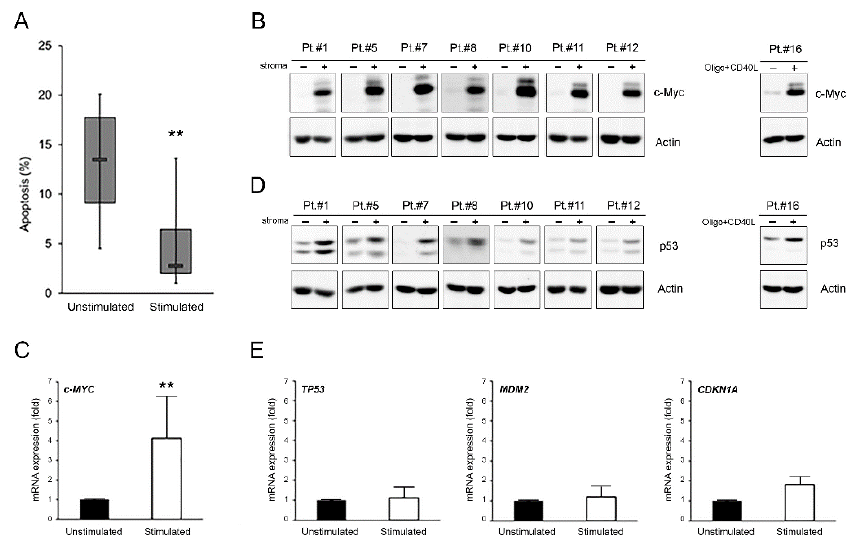
Figure 1. c-MYC and p53 induction in microenvironment-activated B-CLL cells. Patients’ derived B-CLL cells were stimulated (with stroma or CpG-ODN and CD40L) for 24 – 48 h or grown unstimulated in suspension as control. In ( A ), baseline apoptosis level, indicated as percentage of Annexin V/PI double positive cells, was comparatively assessed in B-CLL cells unstimulated and stimulated with stroma at 48 h. Horizontal bars are median, upper and lower edges of box are 75th and 25th percentiles, lines extending from box are 10th and 90th percentiles. The two asterisks indicate p < 0.01 with respect to unstimulated cells (Student’s t -test). Results are reported as mean ± SD of four independent experiments. In ( B , D ), Western blotting analyses of c-MYC and p53 protein levels are shown at 24 h for representative B- CLL patients. β -actin levels are shown as loading control. In ( C ) and ( E ), levels of c-MYC, TP53, MDM2, and CDKN1A mRNA were analyzed by qRT-PCR at 24 h in B-CLL cells unstimulated and stimulated with stroma and expressed as fold of modulation with respect to the B-CLL cultures grown in suspension without stimulation (unstimulated, set at 1). Results are reported as mean ± SD of three independent experiments. The two asterisks (**) indicate p < 0.01 with respect to cells grown untreated in suspension (unstimulated) (Student’s t -test).